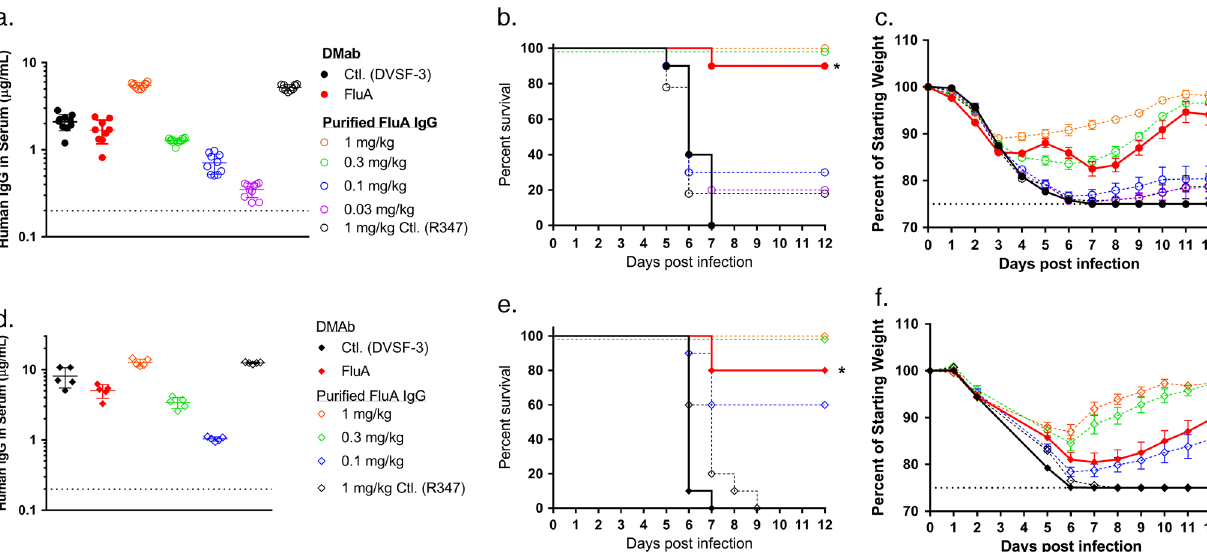
Fig. 3 FluA DMAb protects mice from diverse lethal in fl uenza A challenges. BALB/c mice were treated with FluA DMAb plasmid DNA ( closed symbols ) 4 – 5 days prior to intranasal infection with A/California/7/2009 H1N1 ( a – c ) or re-assorted rA/HongKong/8/68 × PR8 H3N1 ( d – f ). 1 day prior to infection, separate mice received 0.03 – 1 mg/kg FluA protein monoclonal antibody i.p. ( open symbols ). Mice treated with 300 μ g irrelevant DMAb (DVSF-3) or 1 mg/kg non-speci fi c protein monoclonal antibody (R347) served as controls. a , d Human IgG in mouse sera at the time of in fl uenza infection. Dotted line indicates LOD. ( a n = 10 animals, d n = 5 animals per group, mean ± SD). b , e Kaplan – Meier survival curves of BALB/c mice challenged with in fl uenza A ( n = 10 animals per group, * p ≤ 0.0001 FluA DMAb versus Control DMAb). c , f Weight of BALB/c mice following in fl uenza A challenge. Dotted line indicates 25% maximum weight loss. ( n = 10 animals per group, mean ± SEM)